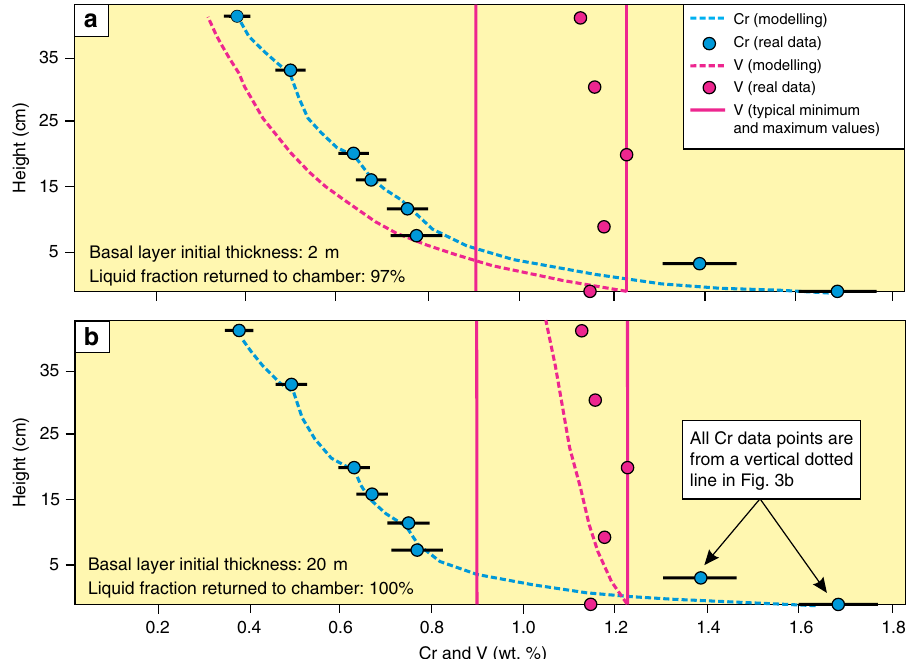
Fig. 7 One dimensional geochemical modelling of Cr and V in the Main Magnetite Layer. a One dimensional modelling of Cr and V in magnetite along a vertical dotted line in Fig. 3b. It is assumed that 97% of rejected melt is removed from the solidi fi cation front and returned to the main magma body. The basal melt layer grows incrementally due to frequent melt additions (Methods). Because fractionation is not perfect, the rate of Cr depletion is much slower, and a relatively thin (2 m) basal melt layer is needed to reproduce the depletion in Cr. In this case the behaviour of Cr and V are similar to each other, with both trace elements being rapidly depleted. However, while the Cr modelling curve matches reality, the modelled V concentration deviates dramatically from typical minimum and maximum values reported in the MML 60 . This approach is clearly not compatible with what is observed in reality. b In this case, it is assumed that perfect fractionation occurs so that 100% of rejected melt is immediately returned to the main magma body from the solidi fi cation front. It is now possible to reproduce the Cr concentration while the V concentration is much closer to reality using a 20 m thick basal melt layer. During the crystallization of massive magnetitite, near-perfect crystal-liquid fractionation must occur (Methods). V concentrations data plotted on this diagram are from Maila 60 as it was not possible to properly quantify V concentrations from our pXRF data. Horizontal black lines indicate the 2 σ analytical uncertainty and are calculated by the instrument during analysis. However, because the Cr concentration is calculated from a Cr/V ratio (Methods), the Cr and V analytical uncertainties are compounded to obtain the fi nal 2 σ analytical uncertainty shown on the fi gure. Analytical errors for V are too small to show but standard deviation following the analysis of several samples are ~0.01 wt.% 60